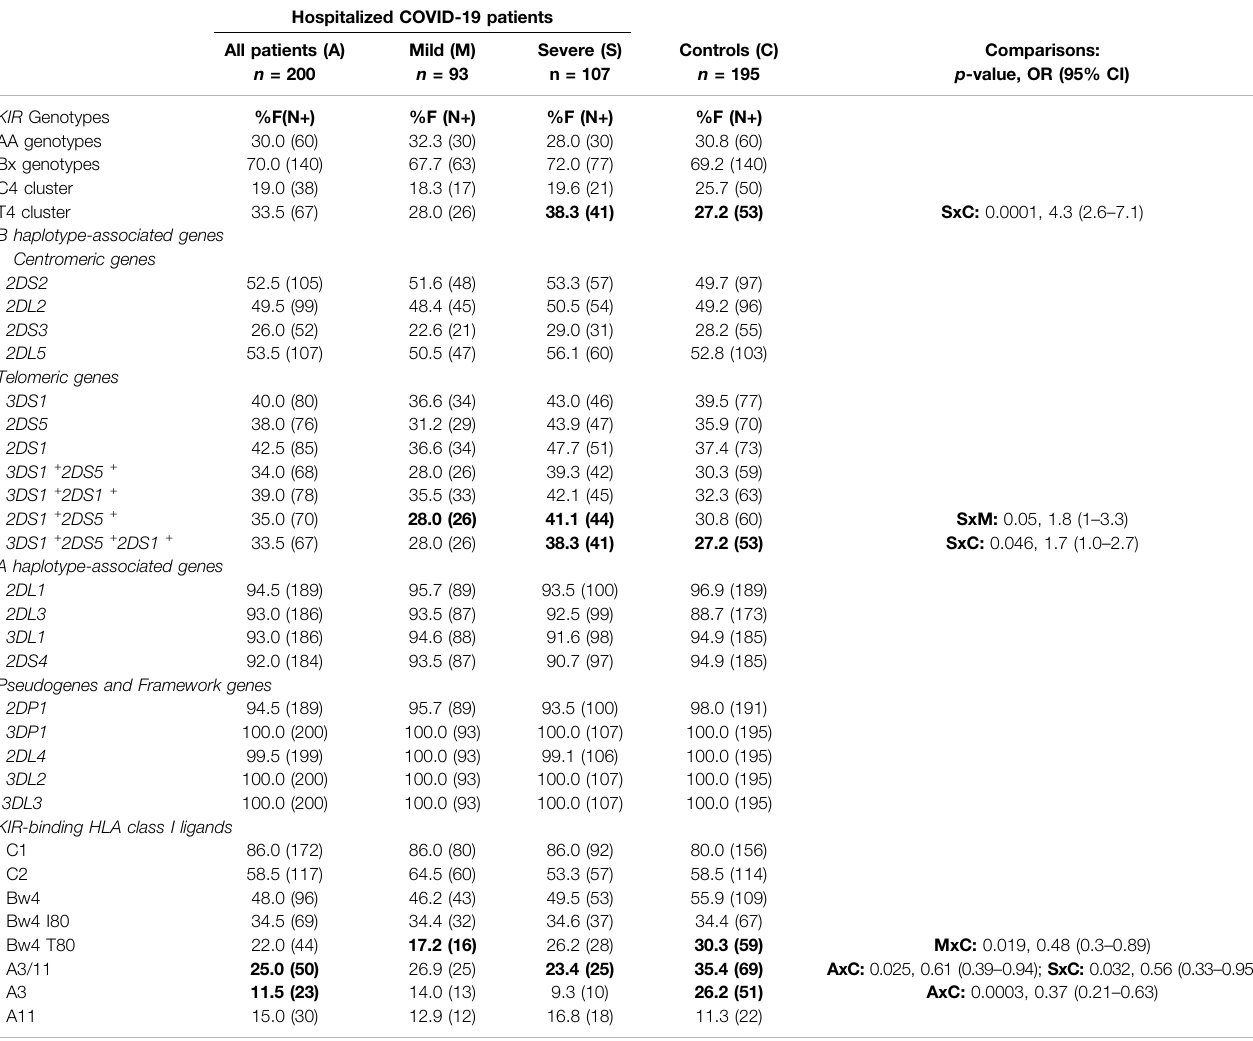
Frequency (%F)of each genotype is expressedas a percentage and de fi ned as the number of individualshaving the genotype (N+) divided bythe number of individualsstudied (n) in the study group;OR, Odds ratio; CI, Con fi dence interval; Comparisons: AxC, all patients vs. controls, MxC, mild vs. controls, SxC, severe vs. controls, SxM, sever vs. mild.Values shows signi fi cant difference are shown in